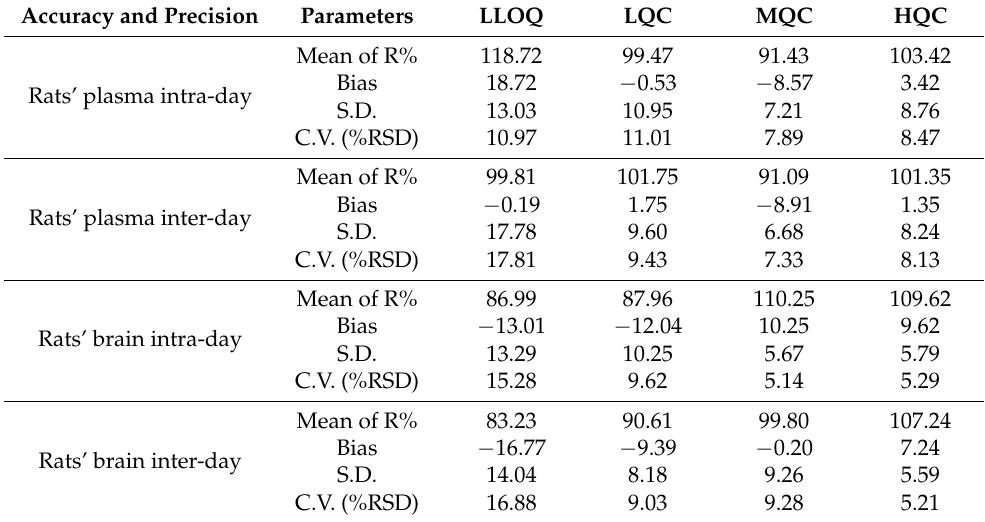
Table 2. Accuracy and precision results for OMR determination by the proposed LC-MS/MS.